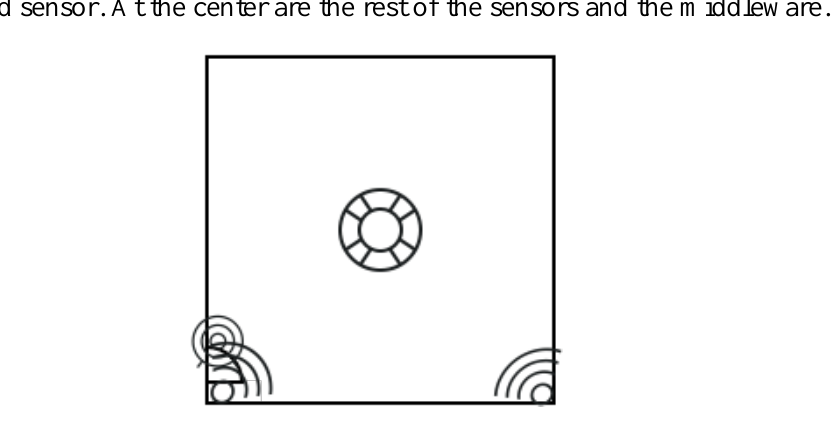
Figure 6. The floor plan of the room. In each corner are the motion sensors and on the door the open/closed sensor. At the center are the rest of the sensors and the